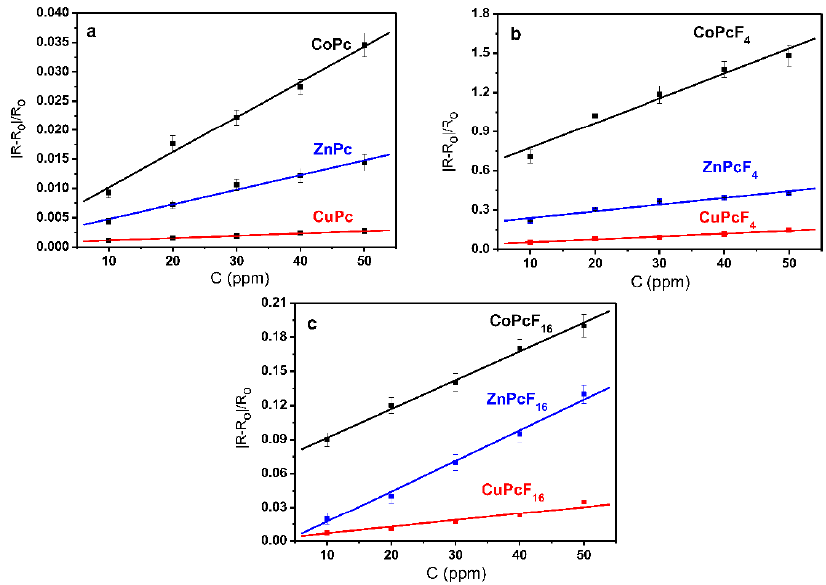
Figure 2. Dependence of the relative sensor response |R-R o |/R o on NH 3 concentration (10–50 ppm) for MPc ( a ); MPcF 4 ( b ), and MPcF 16 ( c ) (M = Zn, Co, Cu)